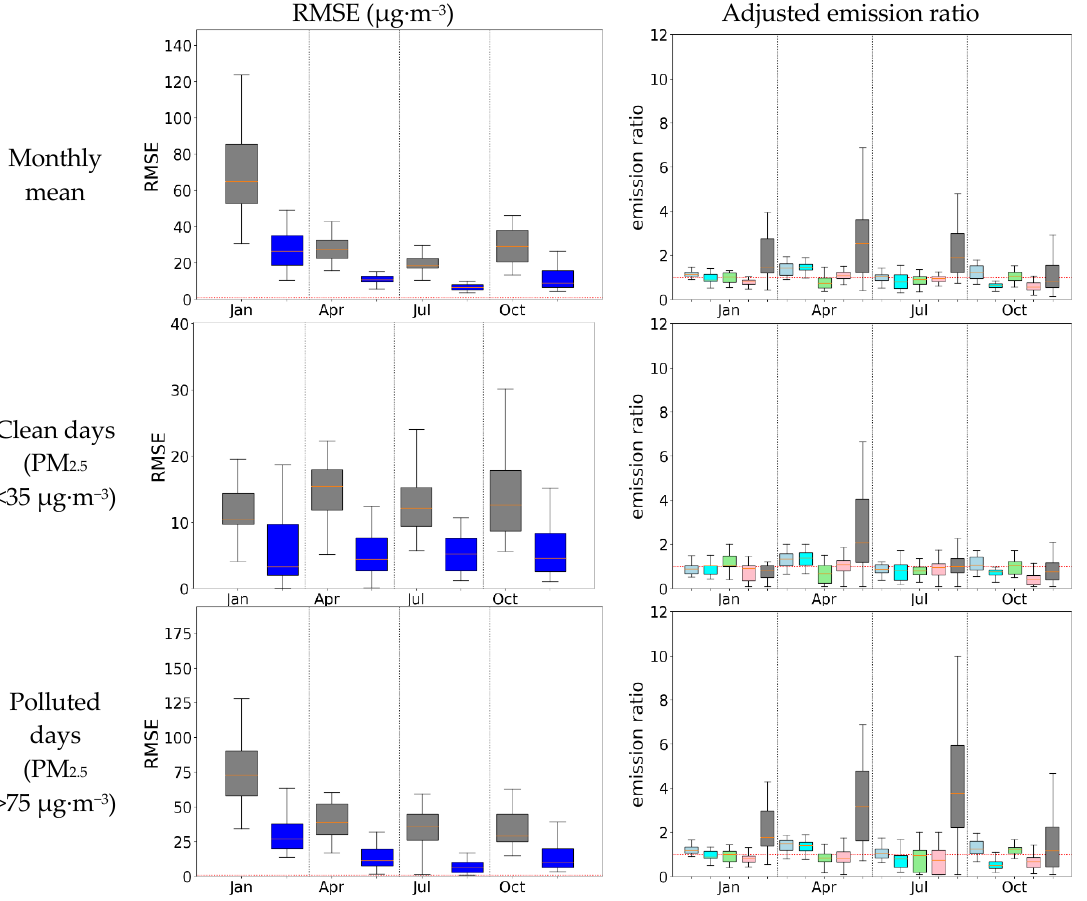
Figure 7. The RMSE (left: grey, CMAQ; blue, RSM) and Adjusted emission ratio for the air quality assimilation (right: baseline = 1. light blue, NO x ; cyan, SO 2 , green, NH 3 ; pink, VOC; grey, pPM 2.5 ) at different polluted levels.